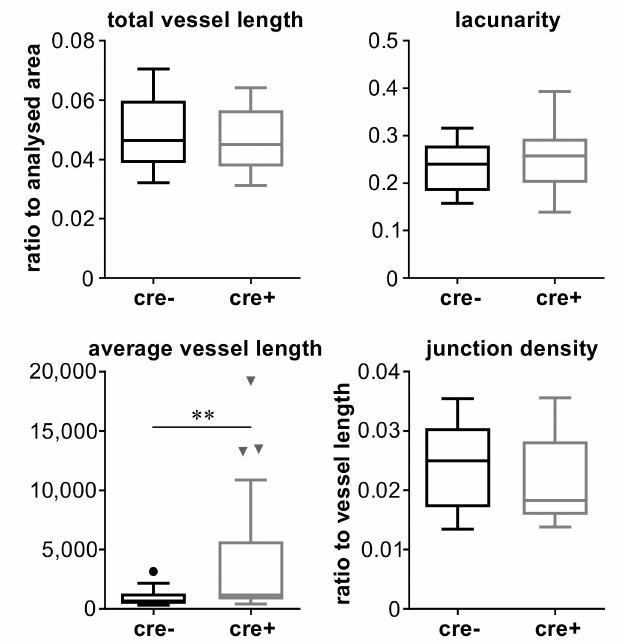
Figure 10. Diagrams showing values of total vessel length normalised to analysed area, lacunarity, average vessel length, and junction density normalised to total vessel length in 12-week-old retinas of Cre-positive mice (knock-outs) and Cre-negative mice (controls) as indicated. Triangles and circles indicate outliers according to Tukey’s presentation of box plots. Statistical significance of differences between the groups is denoted by asterisks: ** p <